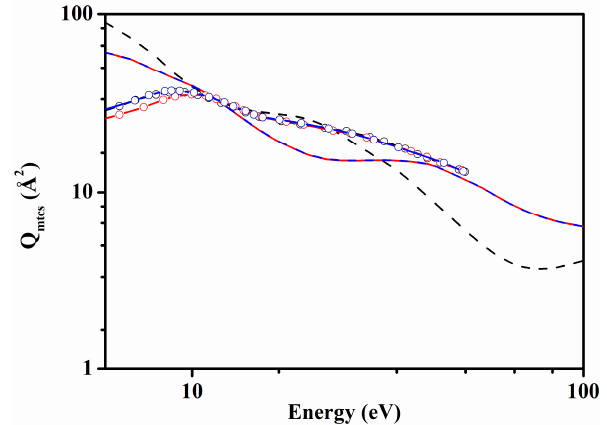
Figure 11. Momentum transfer cross-section for butanol isomers: present results are depicted as lines and results from Bettega et al. are shown as lines with open circles. Butan-2-ol results are shown in black, 2-methylpropan-1-ol in red and 2-methypropan-2-ol results in blue colour.